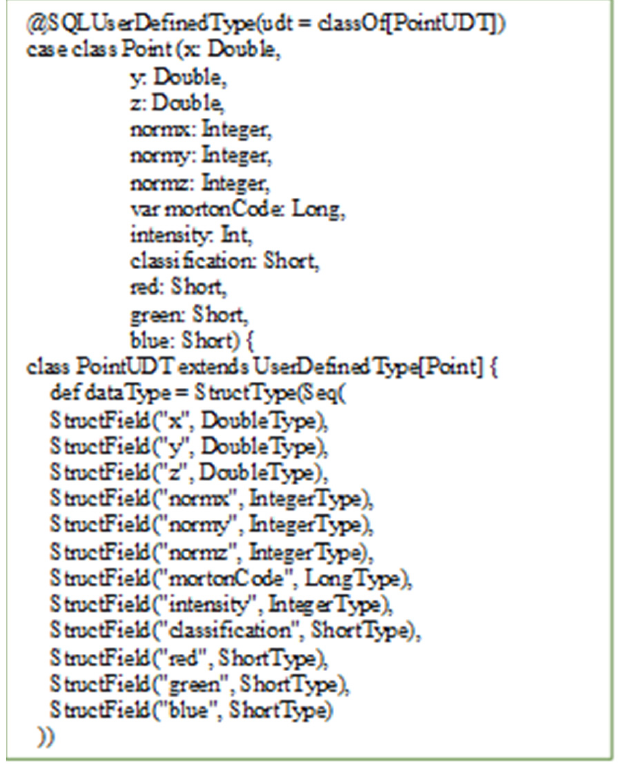
Figure 6. U ser defined type (UDT) class point. Figure 6. User defined type (UDT) class